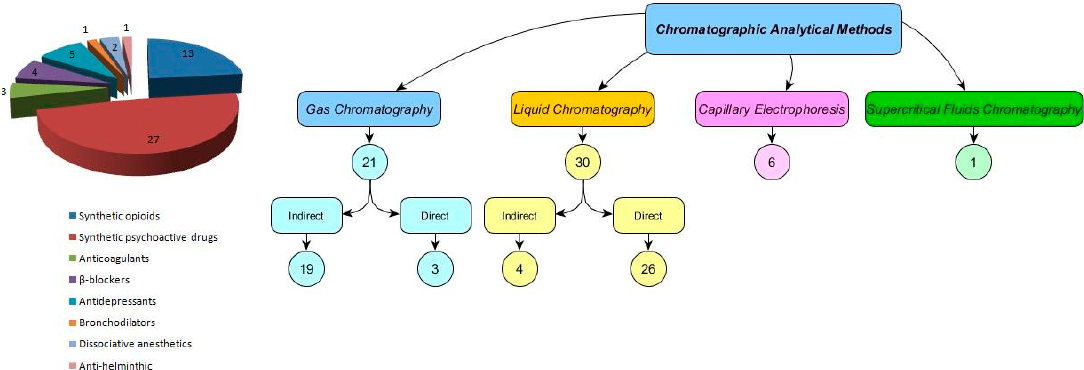
Figure 2. Relative number of each class of chiral drug referred in the reviewed enantioselective published studies and the analytical methods used for separation of the chiral drugs in biological fluids.